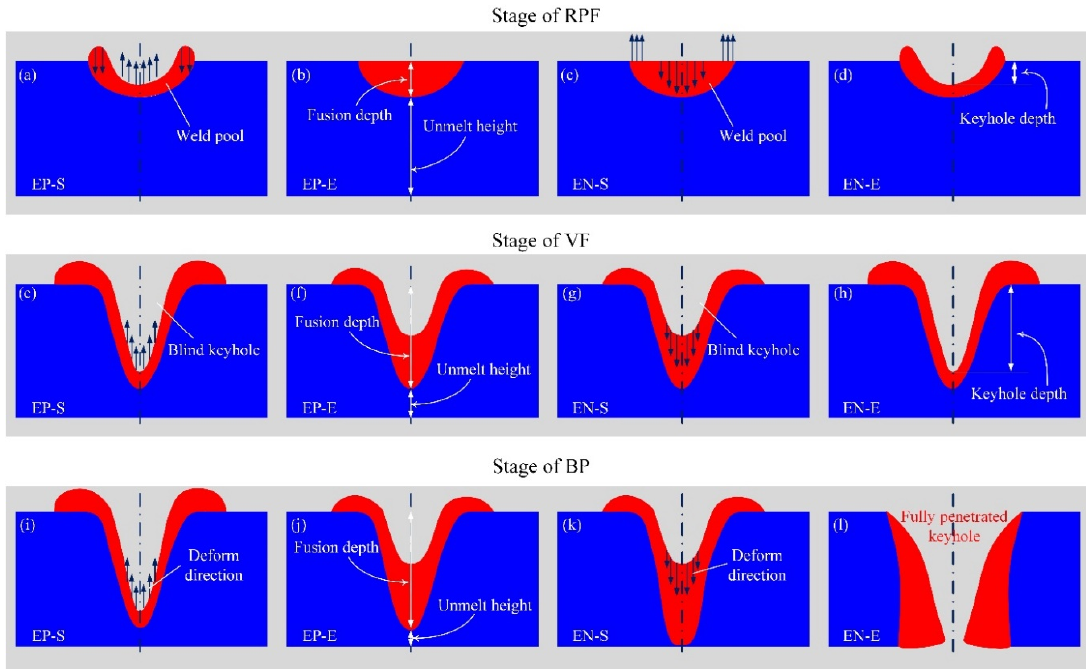
Figure 11. Diagram of keyhole and weld pool in the three stages during digging process. ( a ) start of